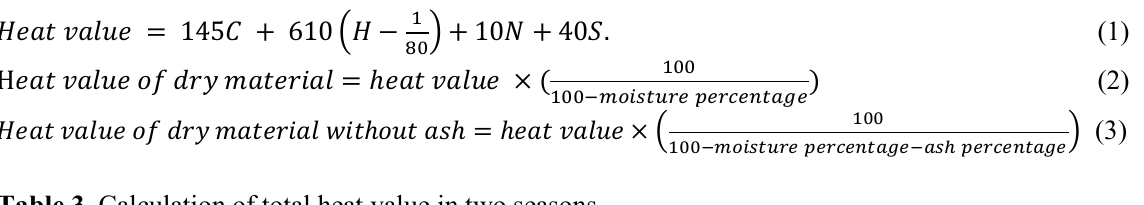
Summer * The first ** The second scenario scenario